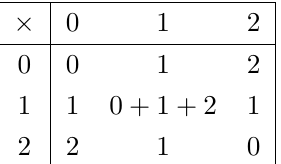
Table 2 . Fusion rules at level k = 3 .